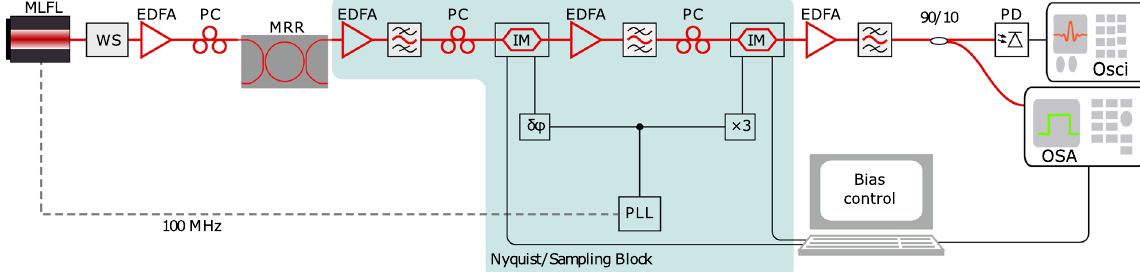
Figure 8. Experimental Setup. The pulses are generated by a mode-locked fiber laser (MLFL), restricted in bandwidth by a waveshaper (WS) and fed into the microring resonator (MRR). The temporal characterization will be done by an electrical sampling scope (Osci), whereas the spectral characterization will be carried out by an optical spectrum analyzer (OSA). Two cascaded intensity modulators with synchronized frequency inputs serve as the Nyquist block, which samples the signal. PC: polarization controller, IM: Lithium Niobate Mach-Zehnder intensity modulator, EDFA: erbium doped fiber amplifier, PLL: phase locked loop for RF signal generation, PD: